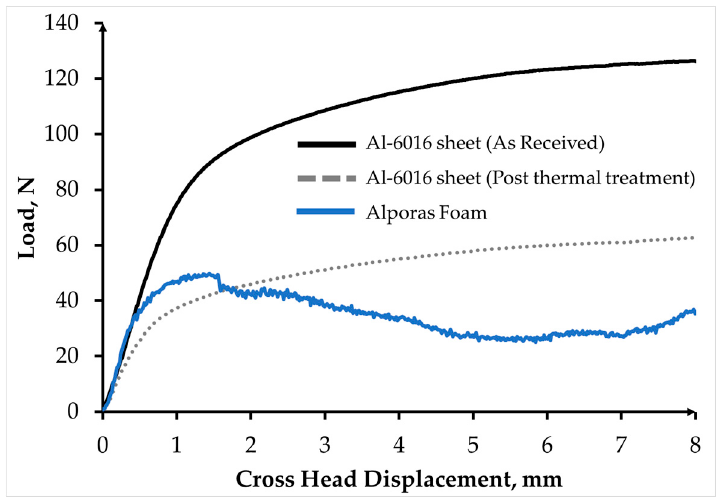
Figure 9. Representative results for base materials of AFS specimens subjected to the three-point bending test.